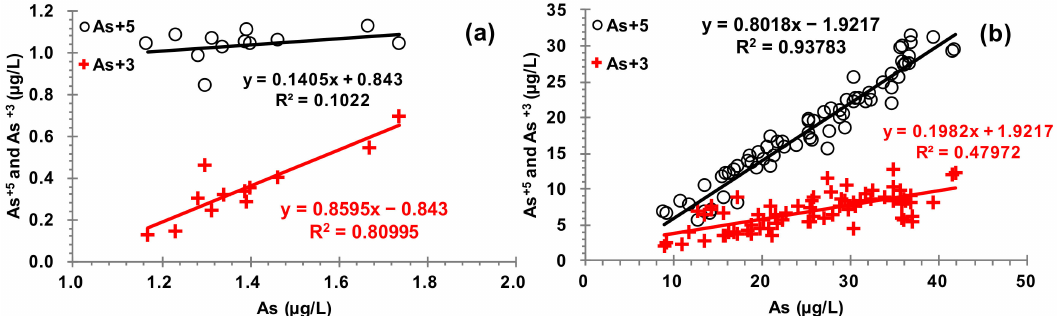
Figure 3. Relationships between As(III/V) and As concentrations in the water of Buha river ( a ) and Lake Qinghai ( b ). In the sediment of Lake Qinghai, arsenic concentration ranged from 12.4 to 21.93 mg kg − 1 (Table 2). The average concentration of As (16.75 mg kg − 1 ) in the sediment of Lake Qinghai is similar to that in the Yangtze’s source area (18.06 mg kg − 1 ) [52], the Yungui Plateau Lake Ecoregion (14.16 mg kg − 1 ) [53] and the 275 alpine/arctic lakes across Europe (12 mg kg − 1 ) [2]. As shown in Figure 4, the average As concentration in the sediment